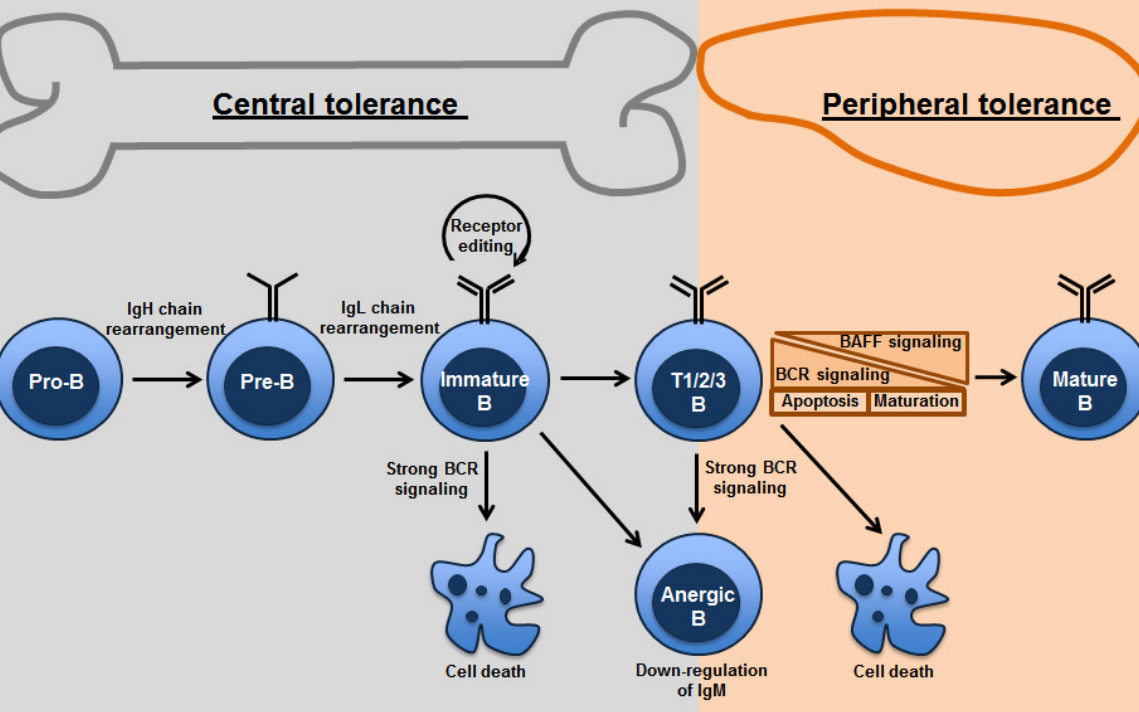
Figure 1. Mechanisms of B-cell tolerance in bone marrow and periphery: Both clonal deletion and anergy are mechanisms utilized in the primary as well as peripheral lymphoid organs. Strength of BCR signaling affects the fate of the B cells undergoing tolerance. Receptor editing occurs primarily in the bone marrow. Transitional B cells are found in the bone marrow and spleen. Peripheral tolerance is primarily found in splenic transitional B cells, which depends on tonic BCR signaling thresholds and survival signals from